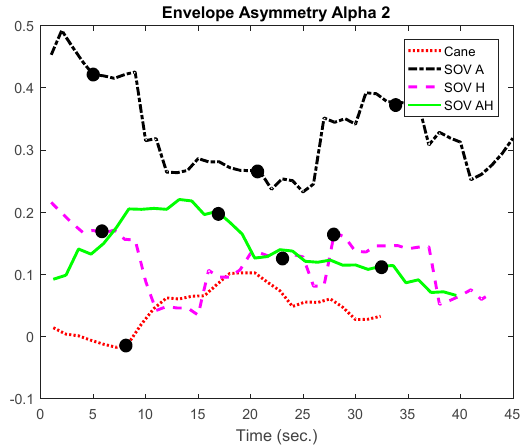
Figure 19. The envelopes of the alpha2 asymmetries for a user who was born blind.